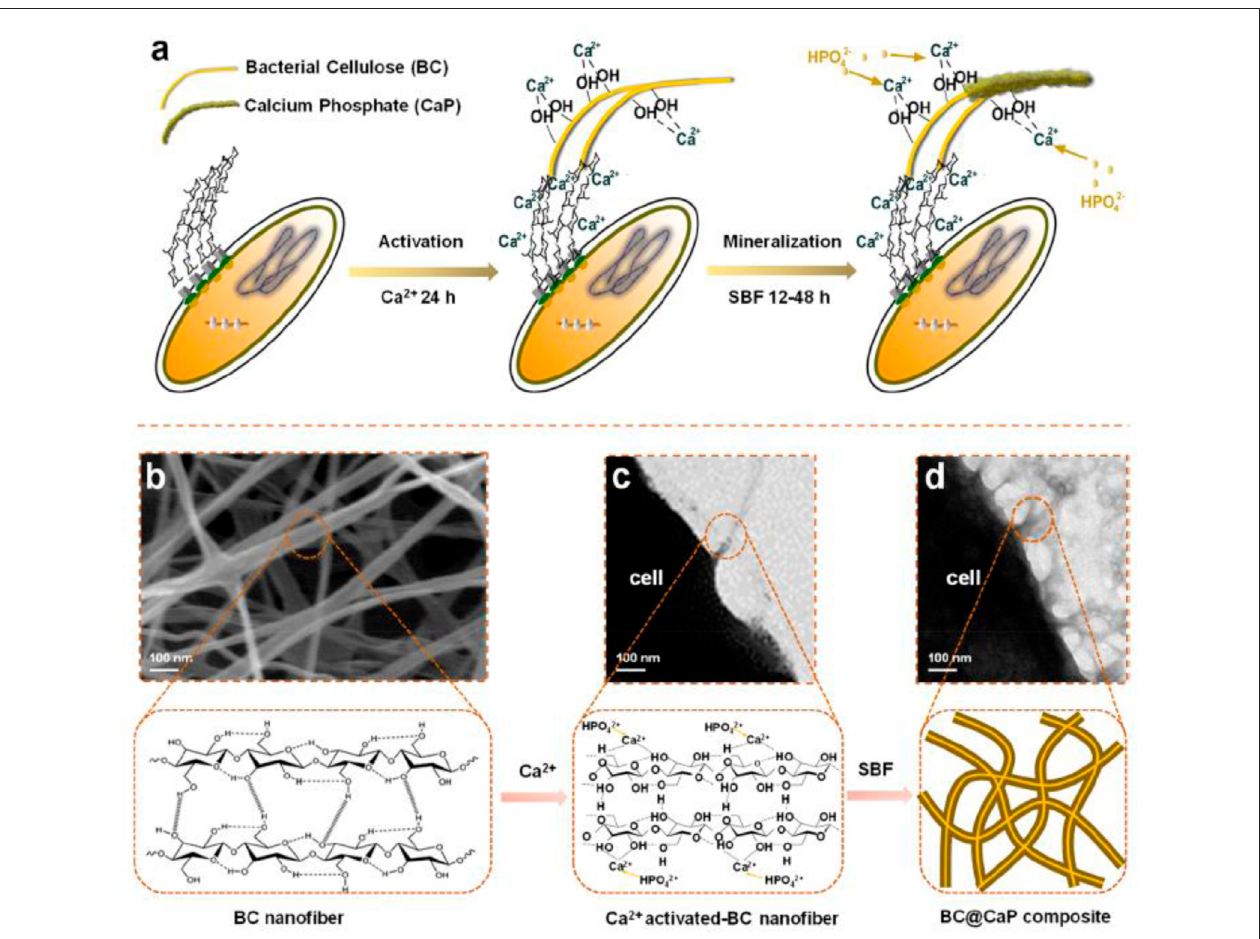
FIGURE 4 | In the experimental design of this study, hydroxyl-rich cellulose molecule chains capture free Ca 2+ to initiate the nucleation of HAp. (A) Schematic diagramoftheformationofHApaccompanyingtheproductionofcelluloseby (A) x. (B) TherepresentativeSEMimageofcellulosenano fi berssecretedbybacterialcells. (C) The representative TEM image ofcellulose nano fi bers secreted bybacterial cells. (D) The representative TEM image ofthe BC@HAp composite was obtained under biological metabolism conditions. (Chen et al., 2021).